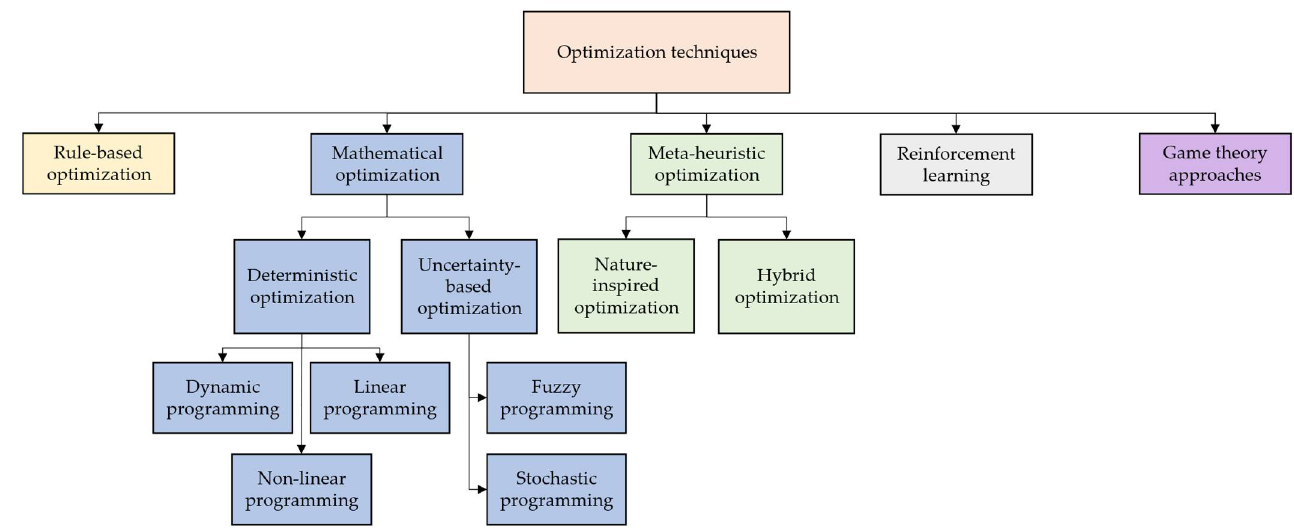
Figure 5. Classification of optimization techniques for energy management systems